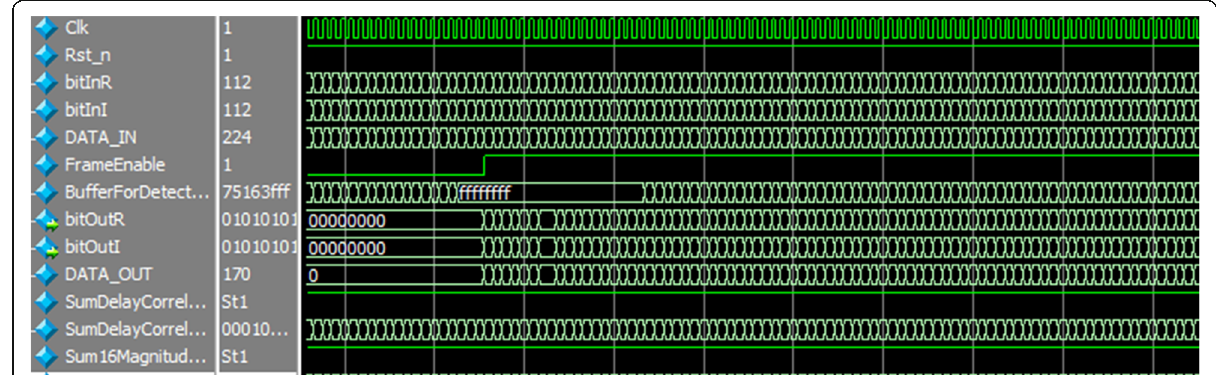
Fig. 6 The simulation diagram 2 of group detection. The value of m n for group detection can be determined by the leading structure when the SNR is